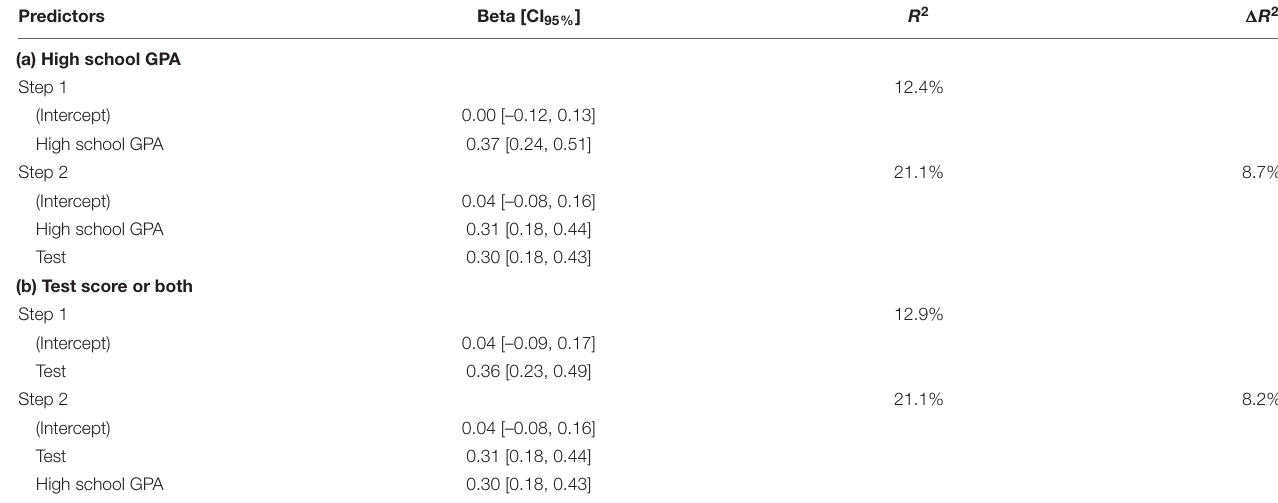
Appendix Table 1 | Simple and multiple linear regression for predicting university grade point average (GPA) with (a) high school GPA, (b) test score or both.